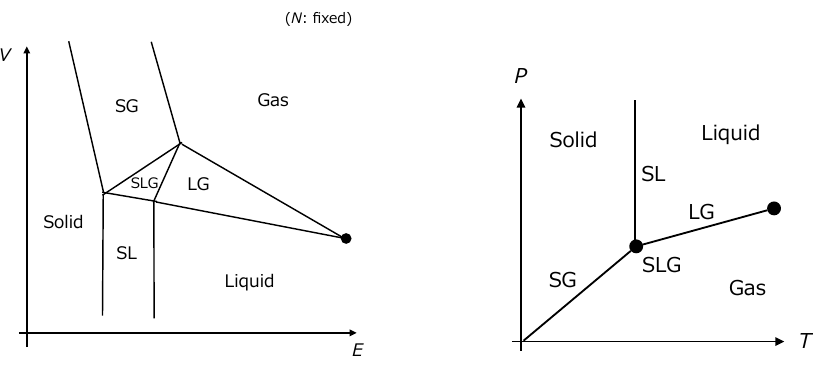
Figure 8 . Schematic phase diagram of vapor-liquid-solid transition in V vs E plane of extensive variables with microcanonical ensemble (left) and P vs T plane of intensive variables with canonical ensemble (right). SL, LG, SG, and SLG denote co-existing phases, with S, L, and G representing Solid, Liquid, and Gas, respectively. Each phase boundary of intensive variables in the right panel corresponds to one of the co-existing phases SL, LG, SG, and